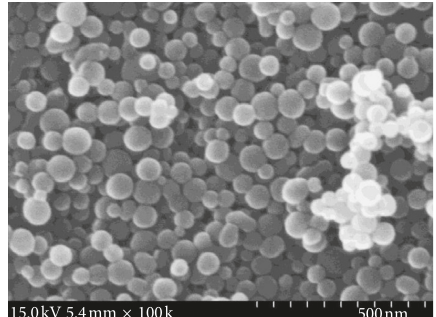
Figure 1: SEM micrograph of silica